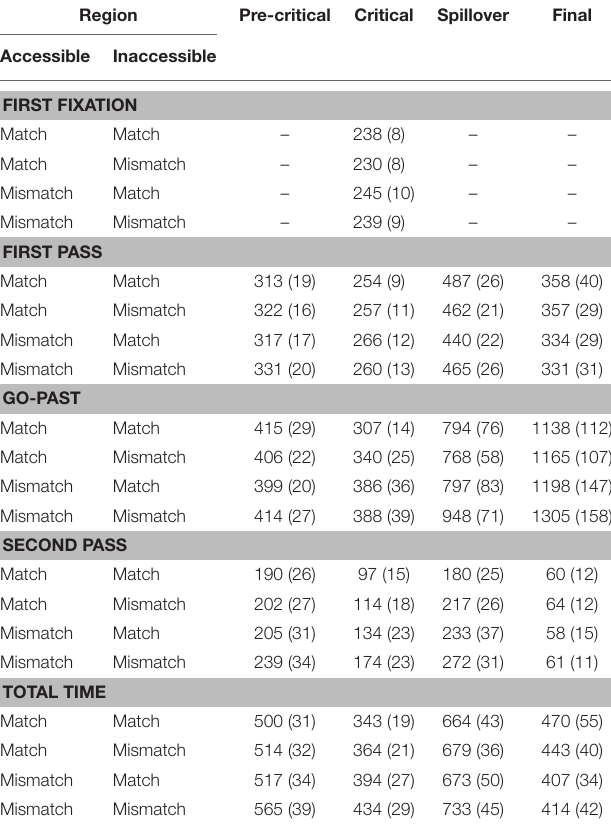
TABLE 5 | Means (and Standard Errors) for Experiment 3. Region Pre-critical Critical Spillover